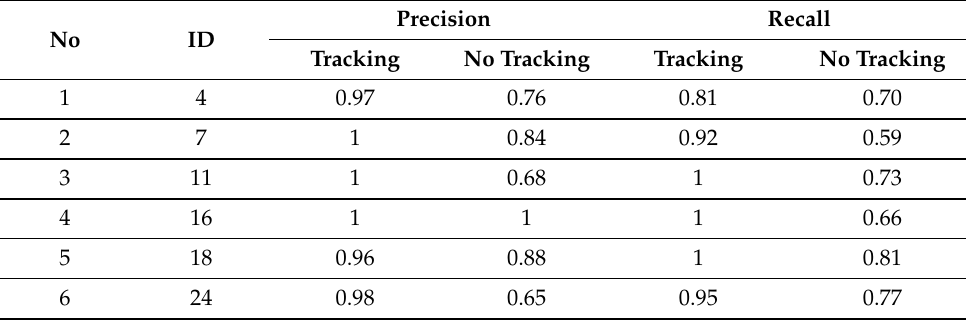
Table 2. Result of precision and recall for the proposed